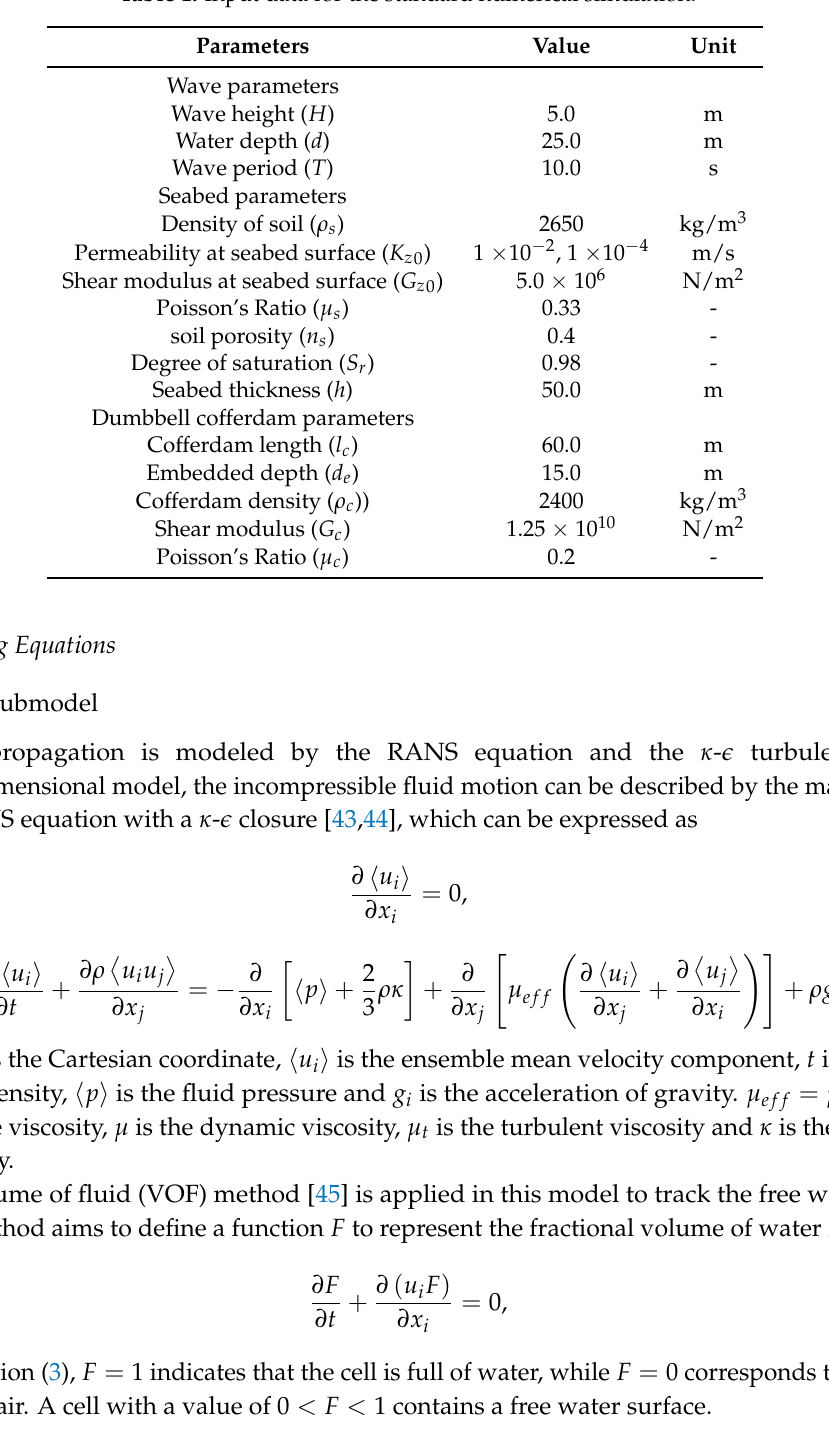
Table 1. Input data for the standard numerical